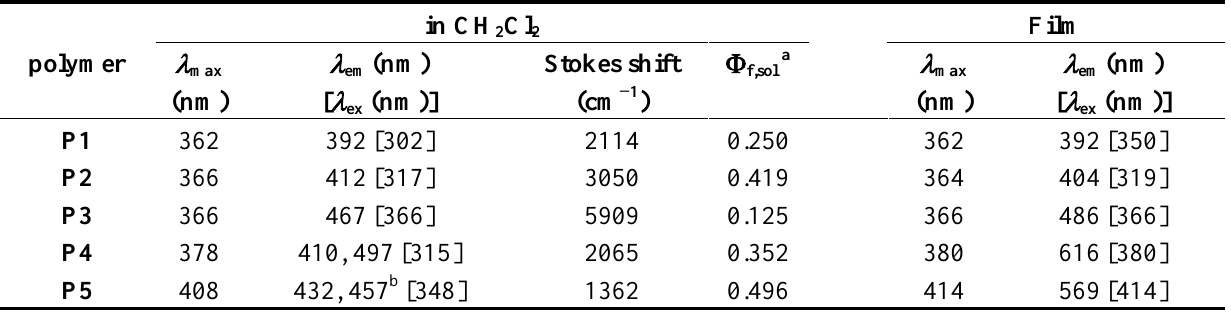
Table 3. Summary of the optical properties of